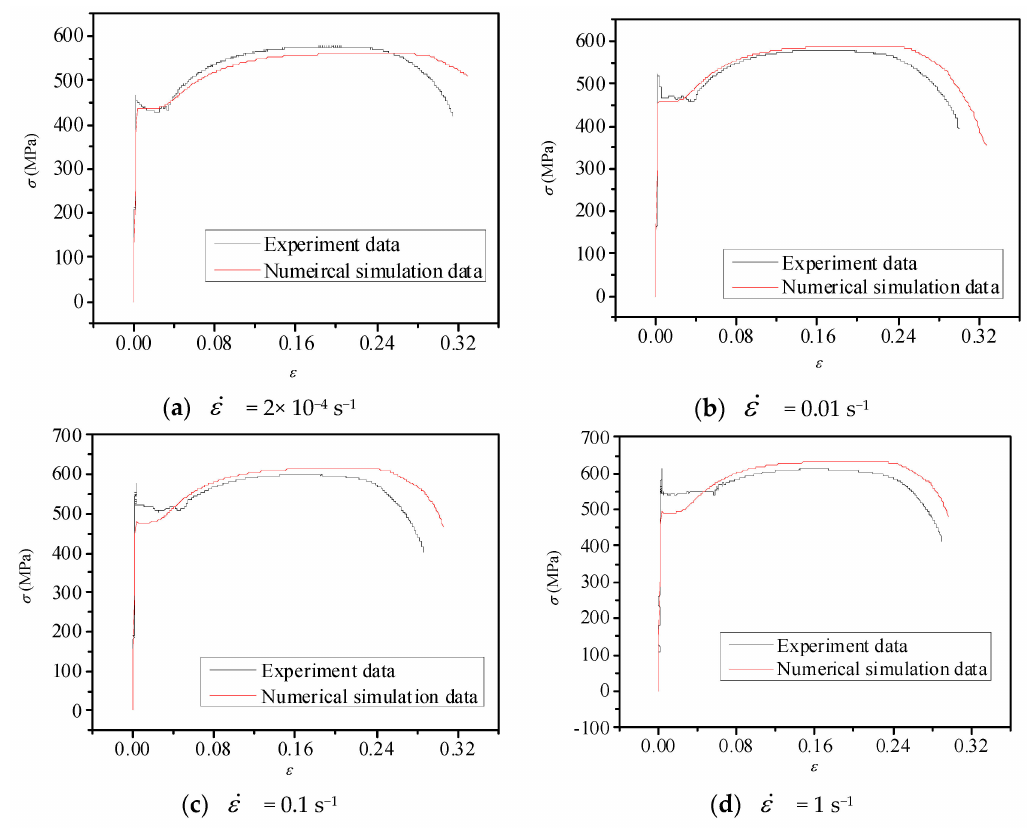
Figure 22. Comparison of numerical and test results at − 60 ◦